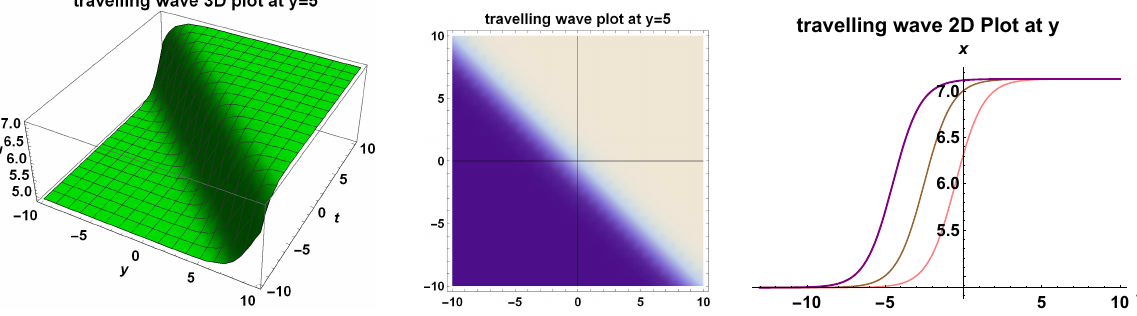
Figure 28. Tavelling wave profile depiction of nontrivial solution (113) at y =